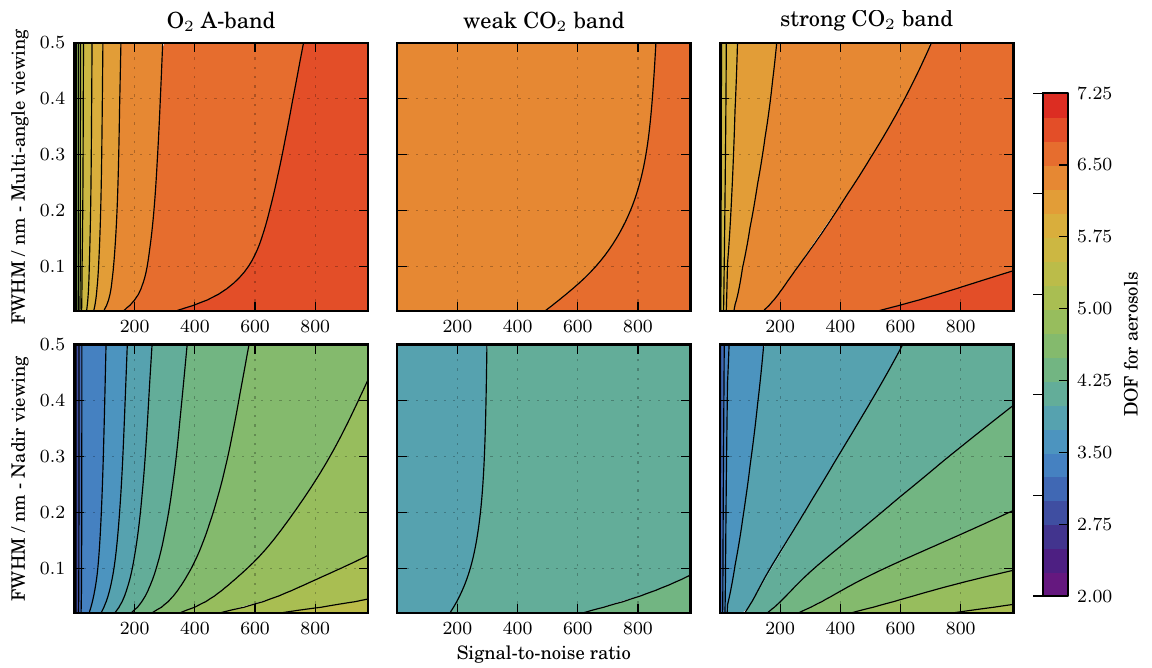
Fig. 7. Small solar zenith angle case ( ≈ 20 ◦ ): contour plot visualisation of the degrees of freedom (DOF) for aerosol state vector elements as a function of signal-to-noise ratio (SNR) and spectral resolution (in full width at half maximum (FWHM) of the instrument line-shape – ILS). Note that oversampling of the ILS increases with FWHM in order to keep the amount of detector pixels used in the retrieval constant. In each panel, specifications of only one spectrometer (left panel: O 2 A-band, middle panel: weak CO 2 band, right panel: strong CO 2 band) were changed while the remaining two were kept at nominal levels: FWHM=[0.04nm; 0.075nm; 0.1nm], SNR=[150; 150; 150] for the O 2 A-band, weak CO 2 band and strong CO 2 band, respectively. The top row shows the multi-angle case, the bottom row the pure Nadir viewing case. Black lines indicate a 0.25 unit change in